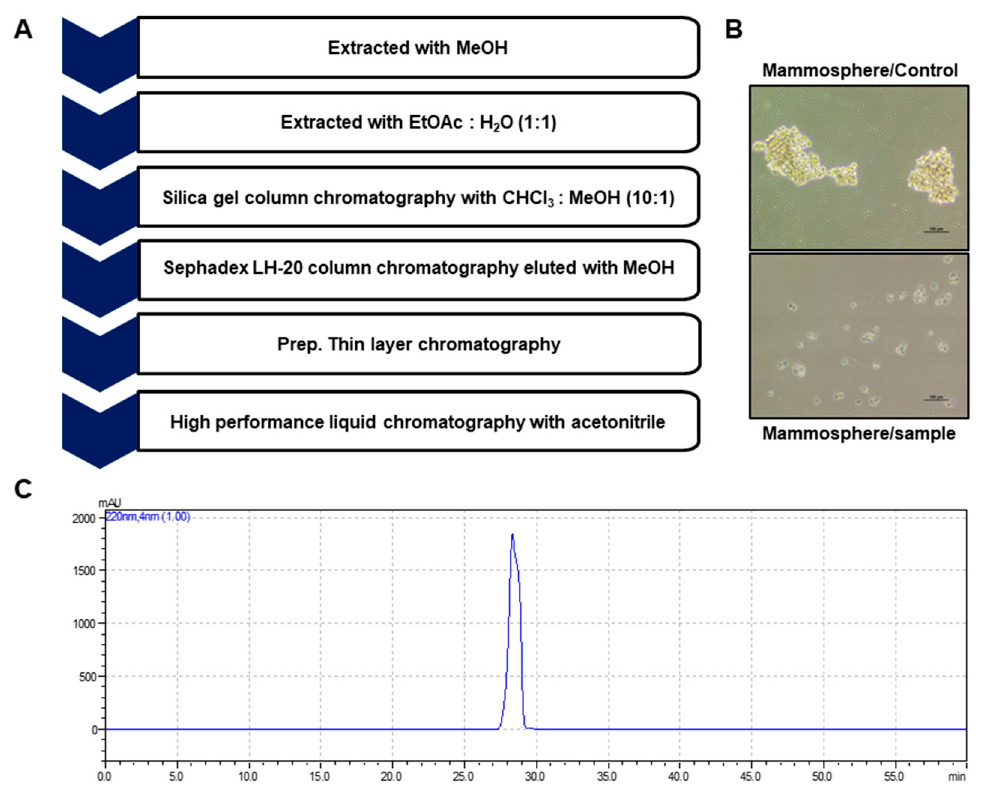
Figure 1. Isolation of breast CSC inhibitors from carrot extracts based on mammosphere formation assays. ( A ) The purification procedure for the mammosphere inhibitor. ( B ) Inhibitory effect of carrot extracts on mammosphere growth. The mammospheres were incubated with carrot extracts or DMSO. The mammospheres were photographed with a microscope at 10x magnification (scale bar = 100 µ m). ( C ) Purified samples of carrot extracts were analyzed by HPLC chromatogram.